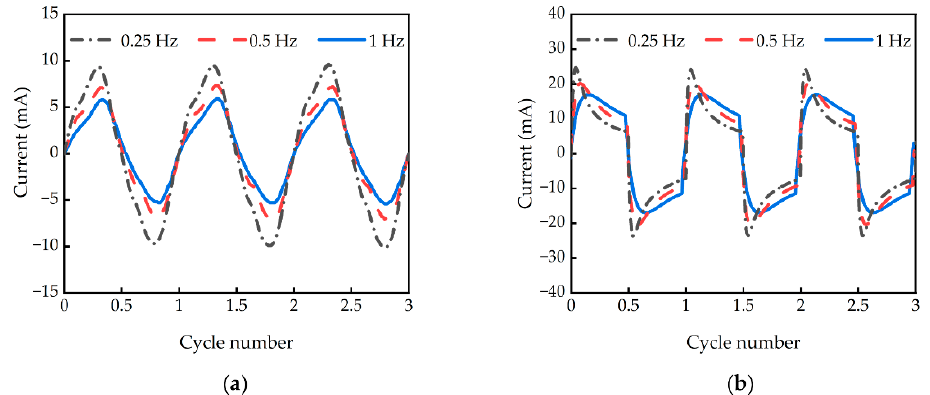
Figure 11. Electric currents of the helical IPMC actuator under different signals with different frequencies: ( a ) sinusoidal signal; ( b ) square wave signal.